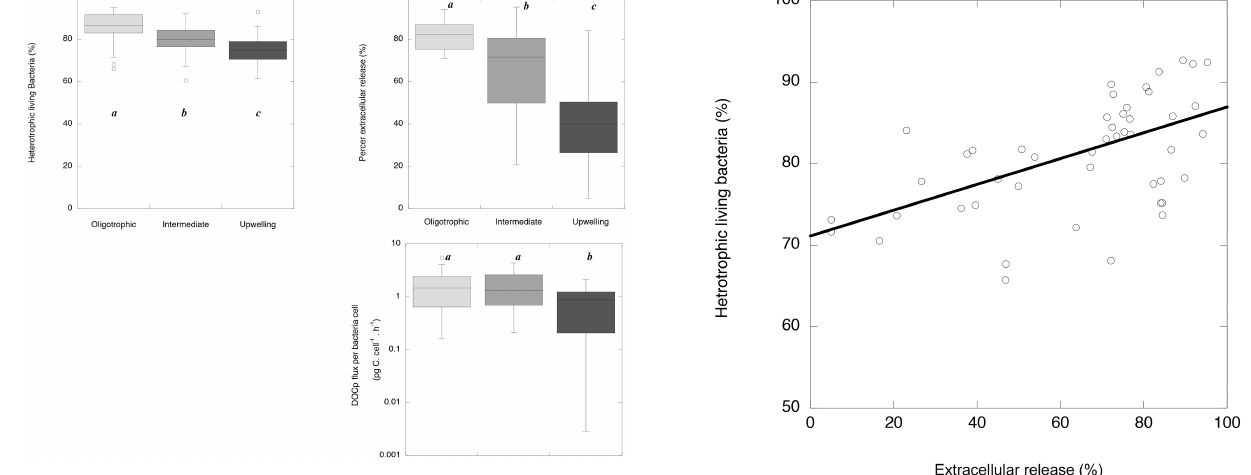
Figure 6. Box plots showing the distribution of the percentage of living bacteria cells, the distribution of PER (percentage of phyto- plankton extracellular carbon release) and the variation of fluxes of DOC p per bacteria at the three sampled zones. The boxes present the lower and upper quartiles, median, minimum, and maximum values, and outliers. The boxes showing the same letter do not have significantly different mean values (Wilcoxon signed-rank test, p < 0 . 05).